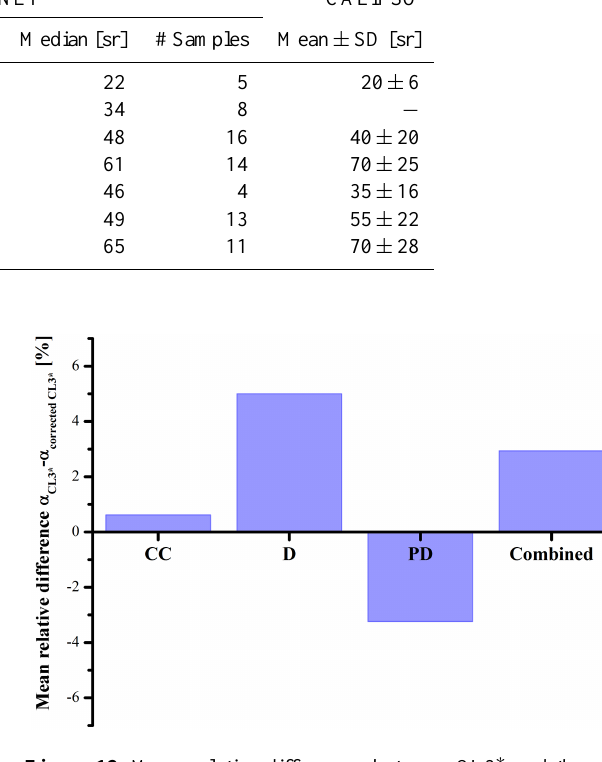
Figure 12. Mean relative differences between CL3 ∗ and the cor- rected CL3 ∗ extinction coefficient. The corrected CL3 ∗ extinc- tion coefficient is retrieved when introducing the EARLINET- estimated lidar ratio for clean continental (CC), dust (D), and pol- luted dust (PD) subtypes as well as for the category Combined (CC + D +